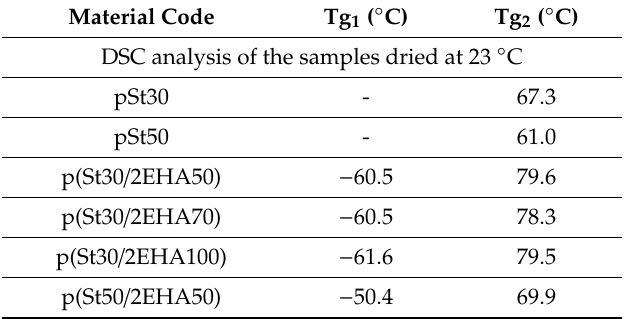
Table 2. Thermal properties of the pSt initial blocks and p(St/EHA) block copolymers obtained by DSC measurements.